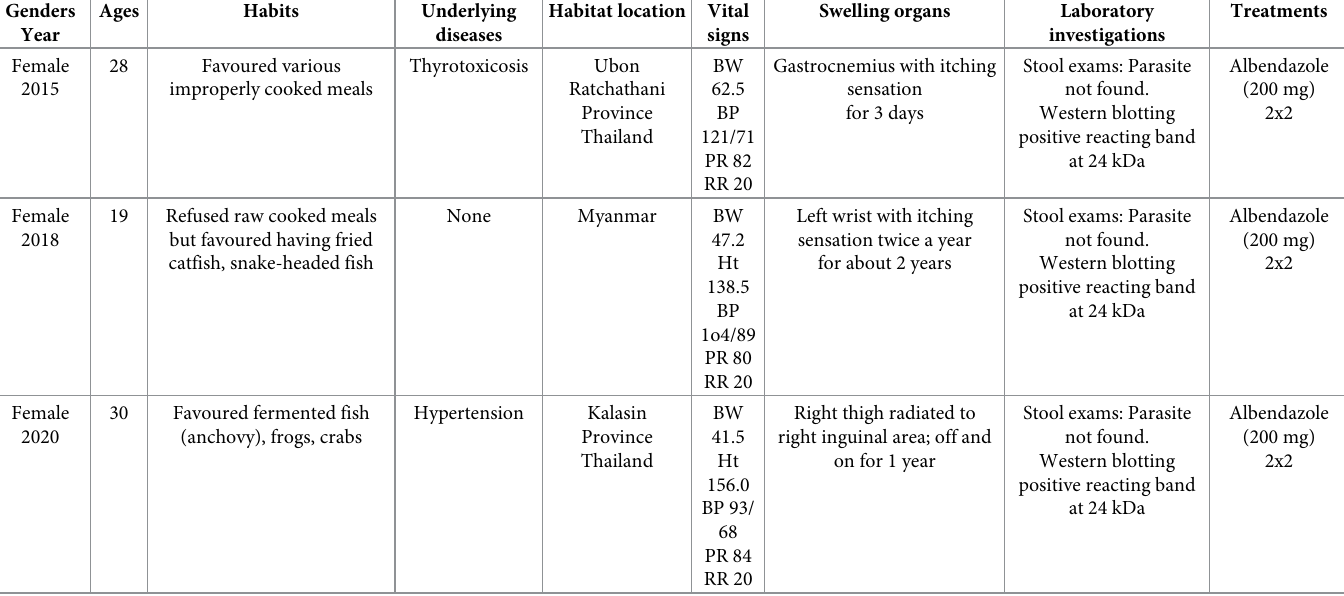
Table 1. Clinical data for three female gnathostomiasis patients who were the source of three recovered